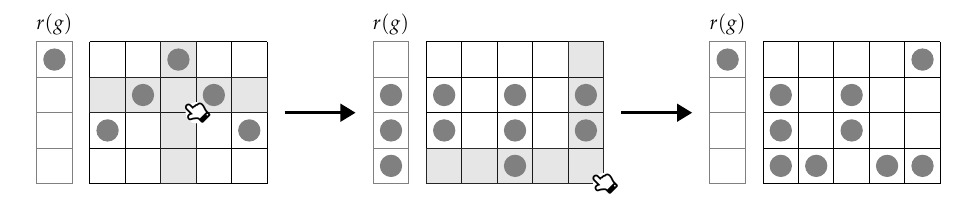
Figure 7. The row parity vector is flipped after performing a